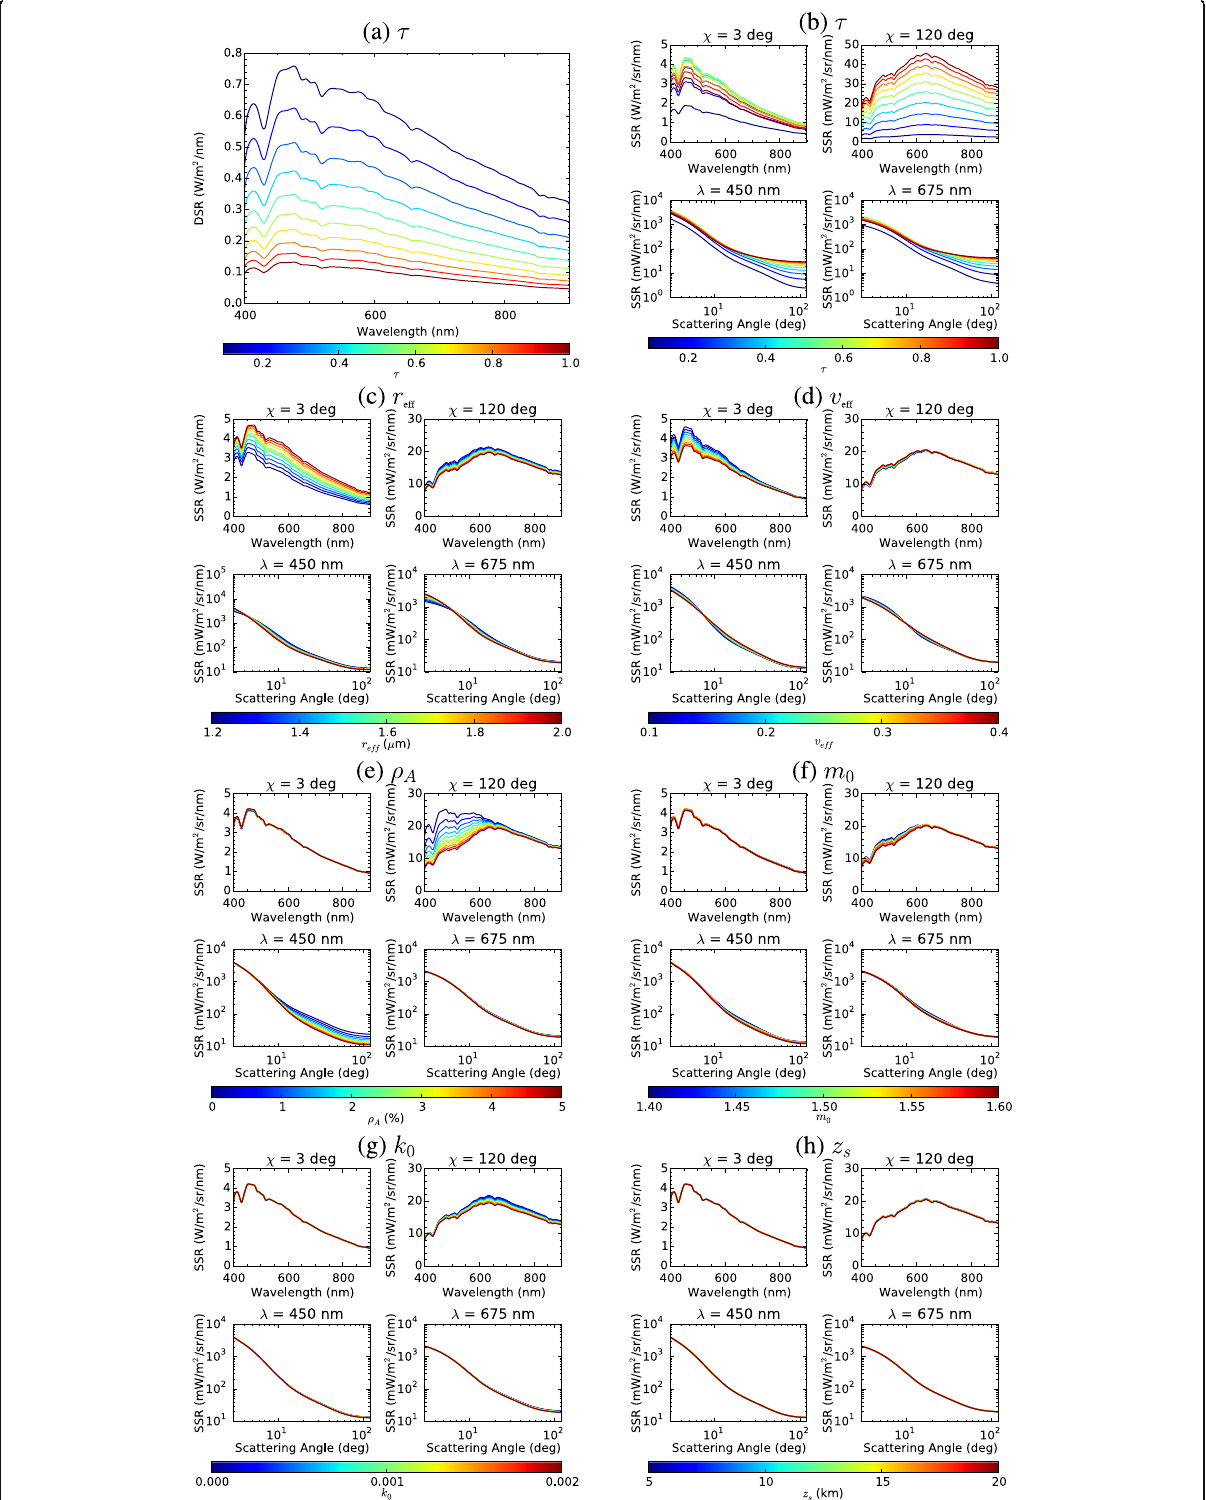
Fig. 2 Sensitivity of ( a ) DSR and ( b – h ) SSR to dust model parameters. DSR and SSR intensities for various values of dust model parameters ( a : τ , b : τ , c : r eff , d : v eff , e : ρ A , f : m 0 , g : k 0 , h : z s ) calculated with a radiative transfer code (MODTRAN5) are plotted as functions of wavelength or scattering